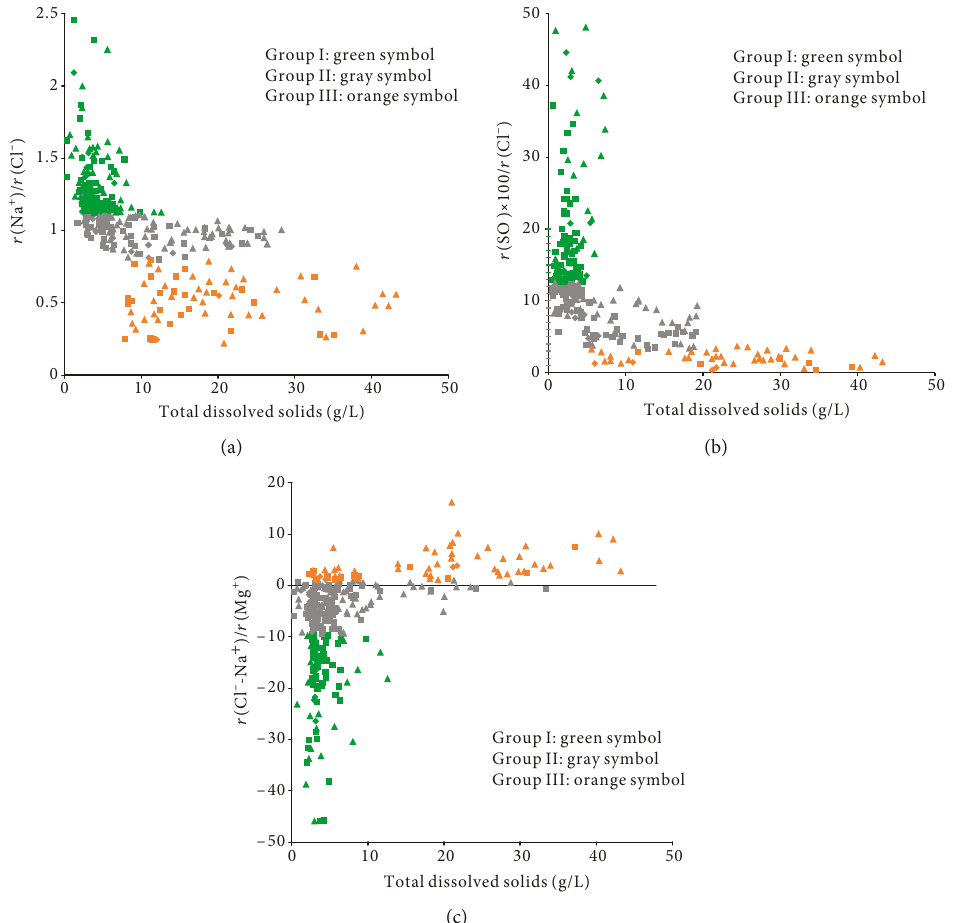
Figure 8: Relationship between TDS and three coe ffi cients of the geothermal water in the study area. (a) Sodium chloride coe ffi cient. (b) Desulfurization coe ffi cient. (c) Metamorphic coe ffi cient. Triangle: Ordovician samples. Diamond: Cambrian samples. Square: Jixian samples.